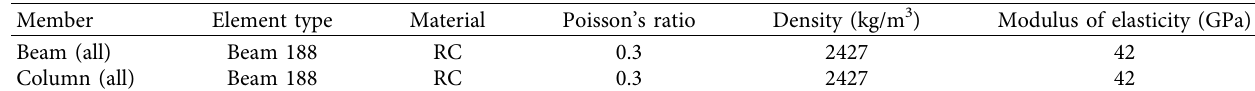
Figure 1: The general modeling scheme and induced damage members of L-shaped structure. (a) 3D view. (b) Plan view. (c) Elevation view. Table 1: Geometric and material properties for